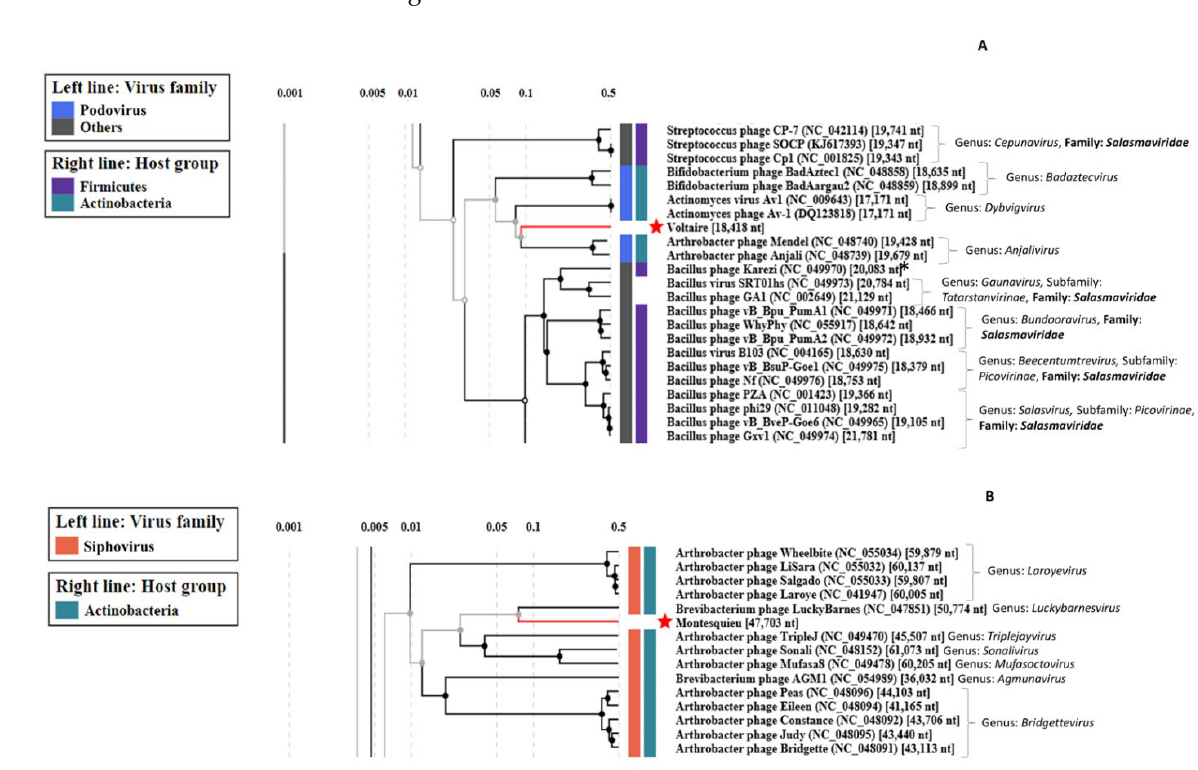
Figure 2. Screenshots of proteomic trees of ( A ) Voltaire and ( B ) Montesquieu and related phages, computed with ViPTree. *: Genus: Karezivirus, Subfamily: Tatarstanvirinae, Family: Salasmaviridae. Red stars indicate the position of the newly sequenced phage